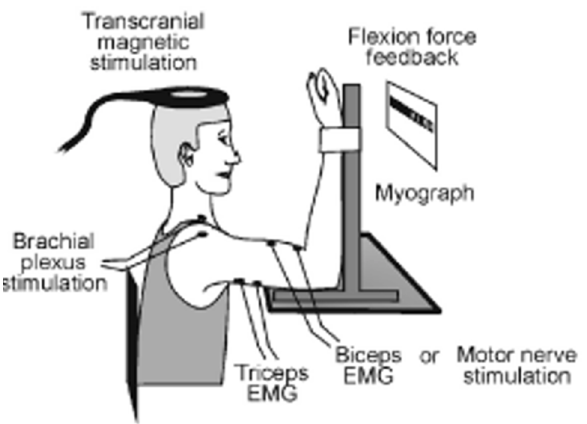
Figure 1. The experimental setup for this study was similar to a previous study (Todd et al., 2003, with permission); however, we used a figure of eight coils, not a circular coil for this current